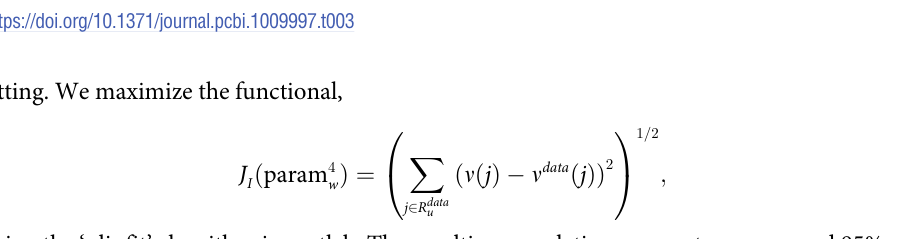
given by Eq (6) u